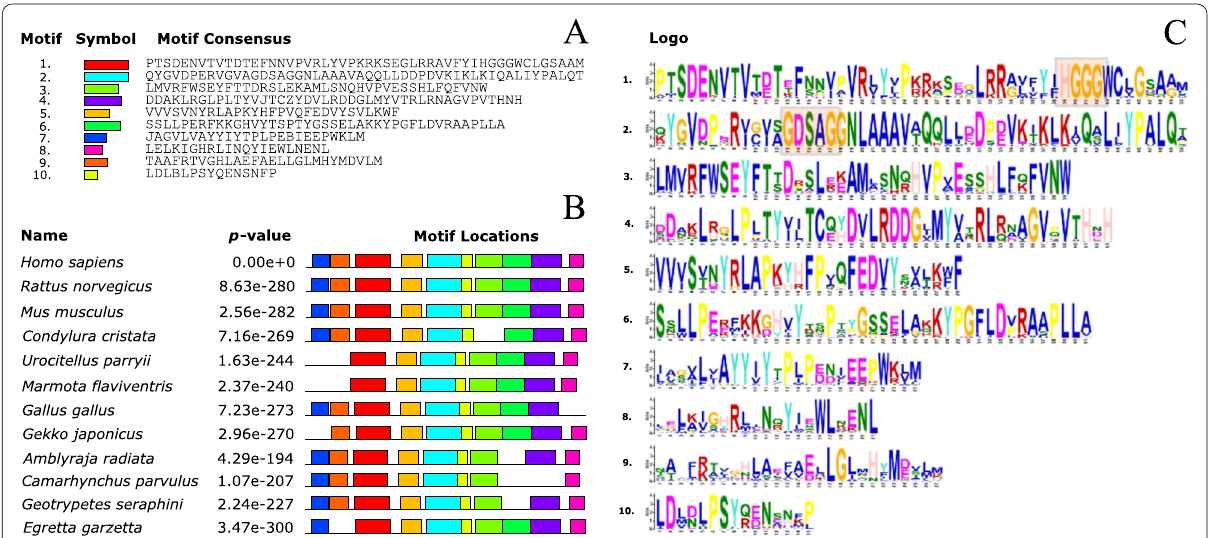
Fig. 5 Conserved motifs in AADAC orthologues using MEME‑suite. A Ten representative conserved motifs. Motif 1 (red), motif 2 (cyan), motif 3 (green), motif 4 (violet), motif 5 (orange), motif 6 (lime), motif 7 (blue), motif 8 (fuchsia), motif 9 (dark orange), and motif 10 (yellow). B The locations along the sequence of the 10 representative motifs depicted in A . The complete list is illustrated in Supplementary Figure S2. C Representation of all motifs of AADACs orthologues. The HGGG and GXSXG motifs are highlighted in gray. N and C, at the bottom of the images represent the amino terminal and carboxyl